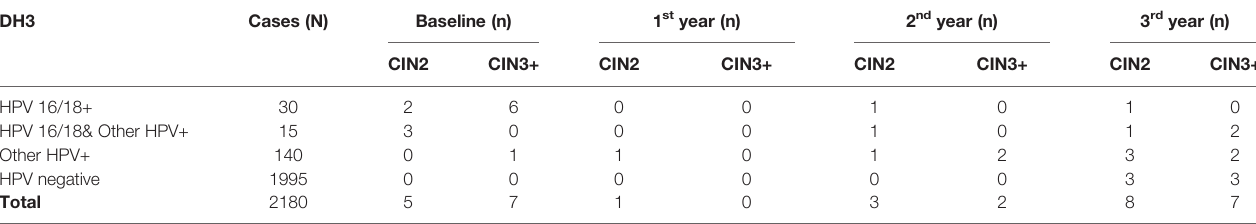
TABLE 1 | Distribution of CIN2+ and CIN3+ cases at baseline and follow up period. DH3 Cases (N)